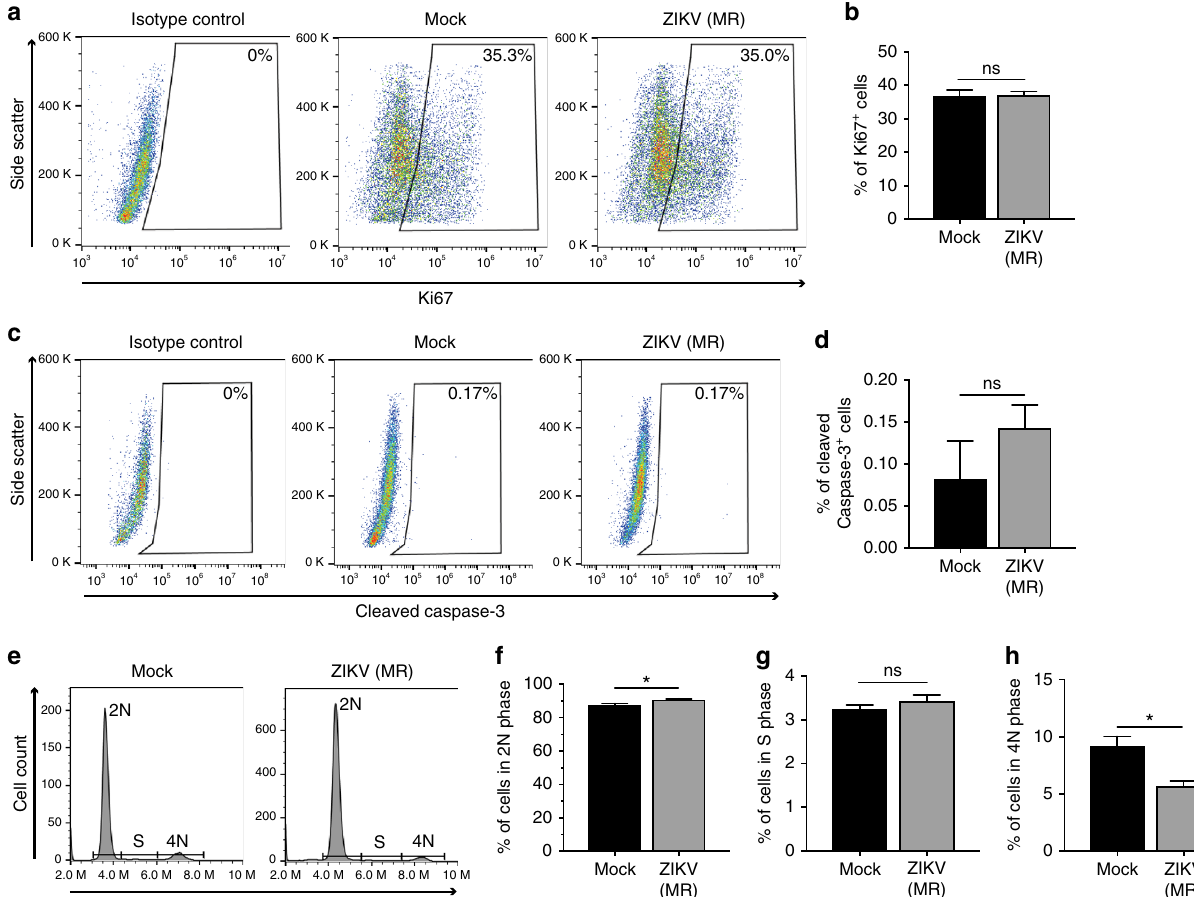
Fig. 3 ZIKV induces minor effects on cell cycle but not on proliferation or survival. a , b Intracellular fl ow cytometry analysis ( a ) and quanti fi cation ( n = 3) ( b ) of Ki67 + GCs 72 h after mock and ZIKV (MOI = 0.1 PFU per cell) infection. c , d Intracellular fl ow cytometry analysis ( c ) and quanti fi cation ( n = 3) ( d ) of cleaved caspase-3 + GCs 72 h after mock and ZIKV (MOI = 0.1 PFU per cell) infection. e – h Cell cycle analysis with fl ow cytometry ( e ) and quanti fi cation of percentage of GCs in 2N phase ( f ), S phase ( g ), and 4N phase ( h ) 72 h after mock and ZIKV (MOI = 0.1 PFU per cell) infection. Statistical values are presented as mean ± s.e.m. and analyzed by two-sided t test and * p ≤ 0.05 or no signi fi cance (ns). Scale bar, 50 μ m. ZIKV strain is MR